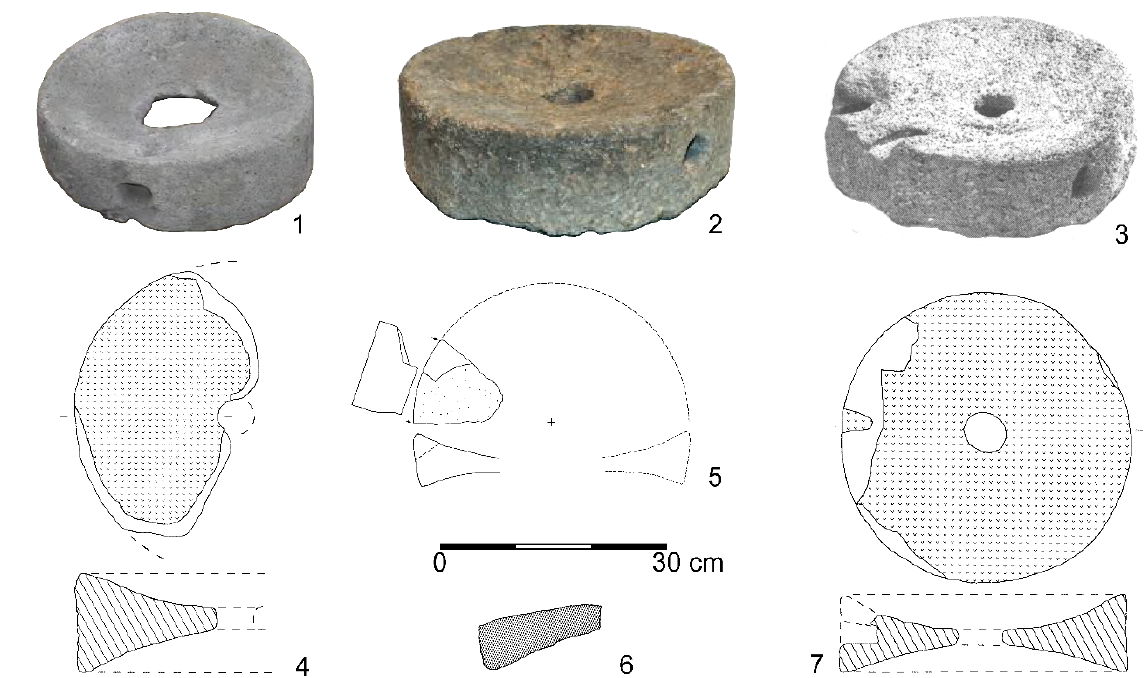
Figure 10. Quernstones of Brillerij type which are not dated by context. 1-5,7: upper stones; 6: lower stone. Provenances: 1. Lierop-Boomen; 2. Neuss; 3. Rossum; 4. Wölferlingen; 5. De Palen, 6. Wederath-Belginum; 7. Starý Kolín. All “basalt”-like lava. (1. Kortlang 2011: fig. 13; 2. Pause 2015: fig. on p. 159; 3. Modderman & Montforts 1991: fig. 11:3; 4. Wefers 2012a: pl. 108:576; 5. Miedema 2002: fig. 179:1; 6. Cordie-Hackenberg & Haffner 1991: pl. 472; 7. Wefers 2012a: pl.